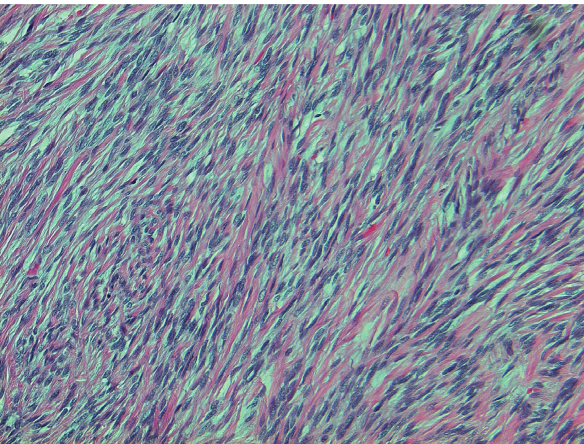
Figure 4: Histologic appearance of solitary fibrous tumor. Pho- tomicrograph of solitary fibrous tumor at 100x magnification demonstrating the classic pattern-less pattern of uniform, spindled to ovoid fibroblastic